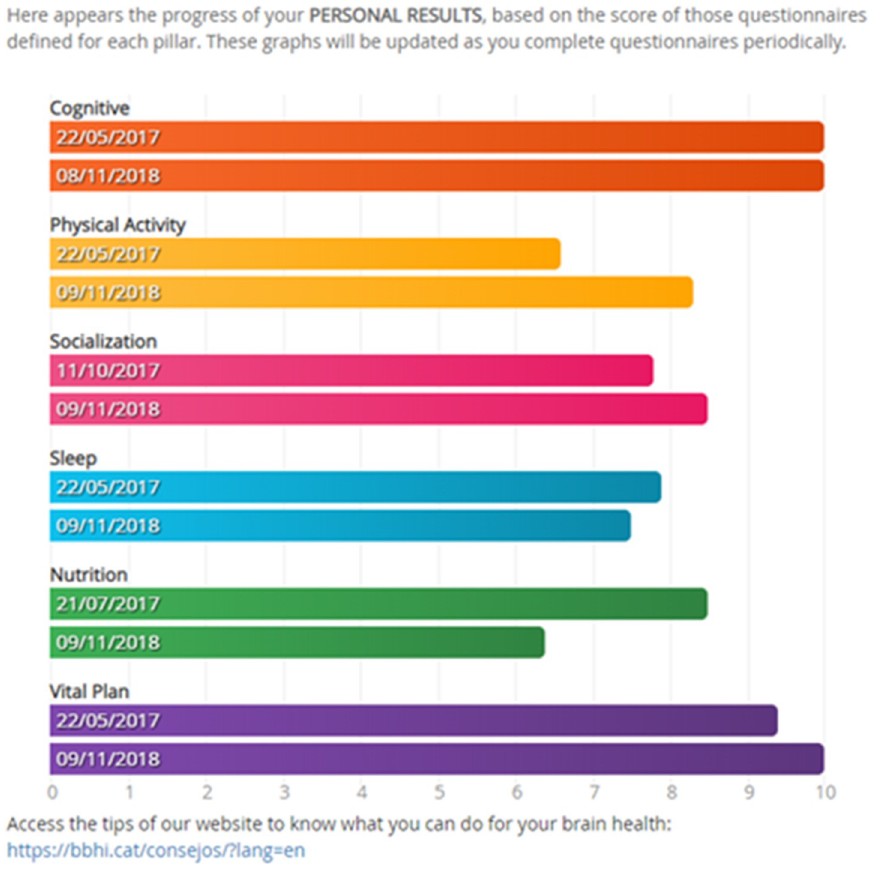
Fig 2. Position of participants respect to other similar